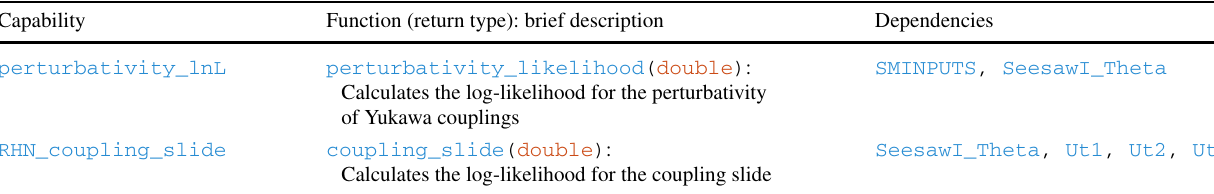
Table 20 Capabilities and module functions for perturbativity constraints and coupling slide